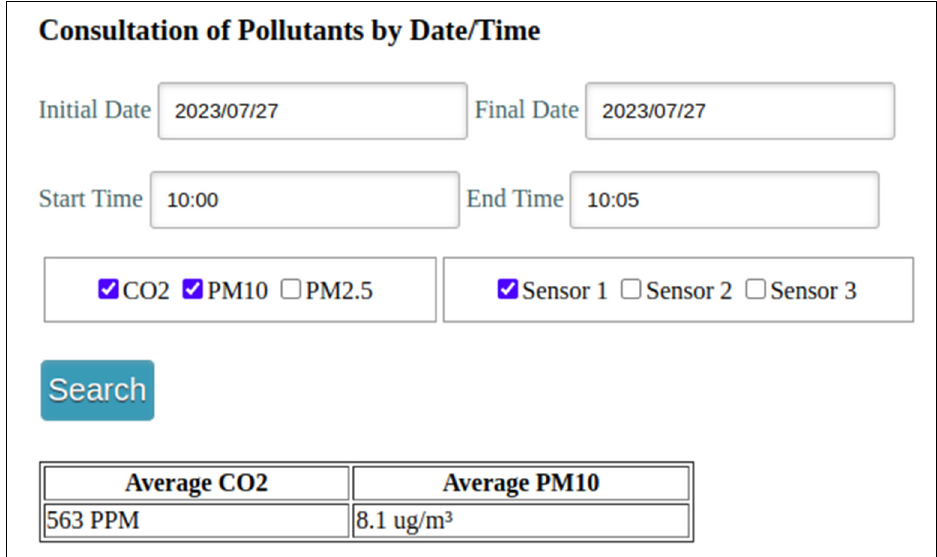
Figure 2. The query module interface screen of the CO 2 and PM monitoring system for showing query versatility through the application of filters.